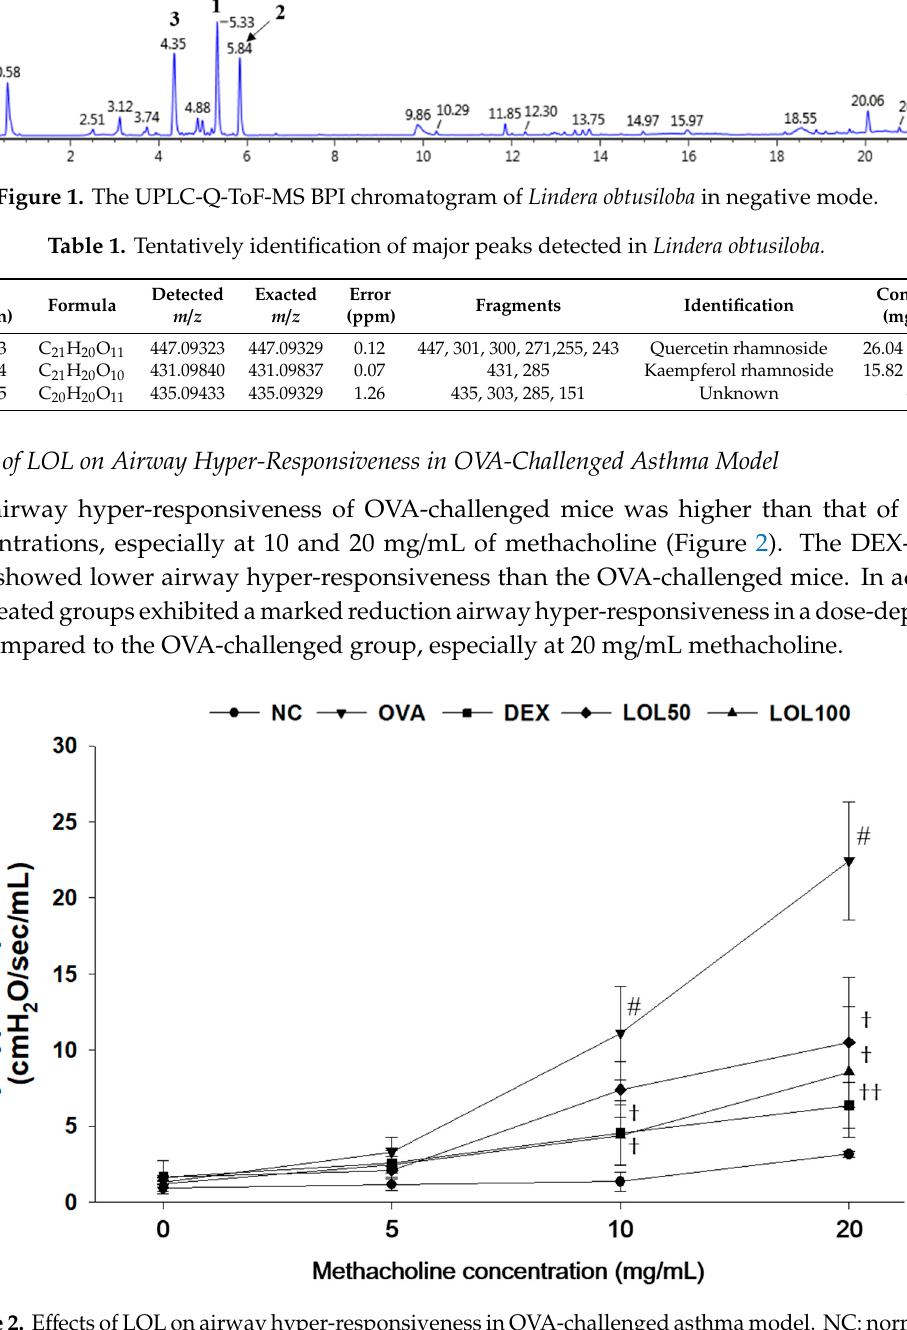
Figure 1. The UPLC-Q-ToF-MS BPI chromatogram of Lindera obtusiloba in negative mode. Table 1. Tentatively identification of major peaks detected in Lindera obtusiloba.